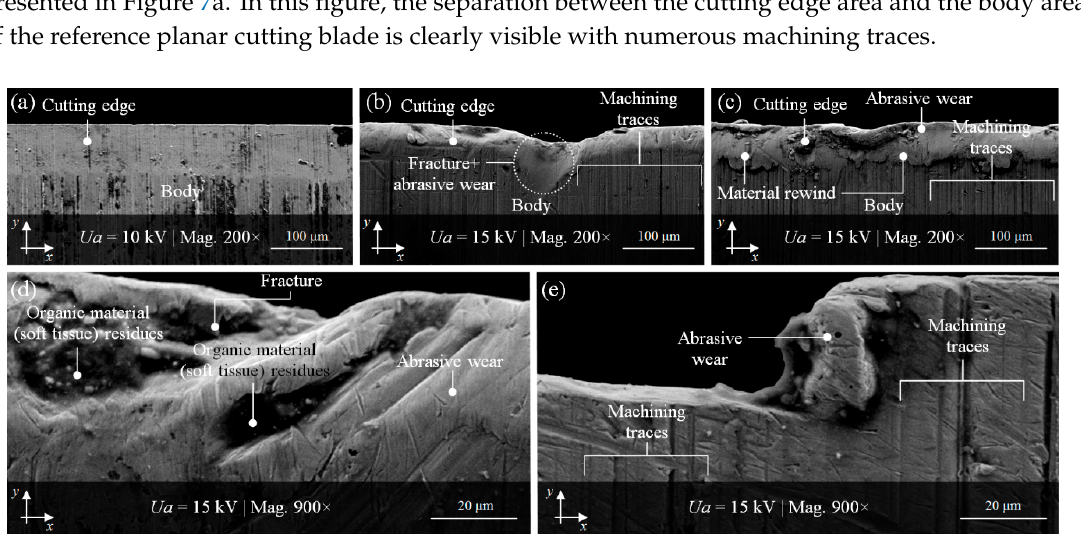
Figure 7. Selected results of SEM imaging (JEOL JSM-5500LV) of planar cutting blades after the intensive technological process: ( a ) nonworn cutting edge (reference, magnification (mag.) 200 × ); cutting edges with visible various degrees of degradation: ( b ) B1-2 (mag. 200 × ); ( c ) B1-3 (mag. 200 × ); ( d ) B1-3 (mag. 900 × ); ( e ) B1-7 (mag. 900 ×